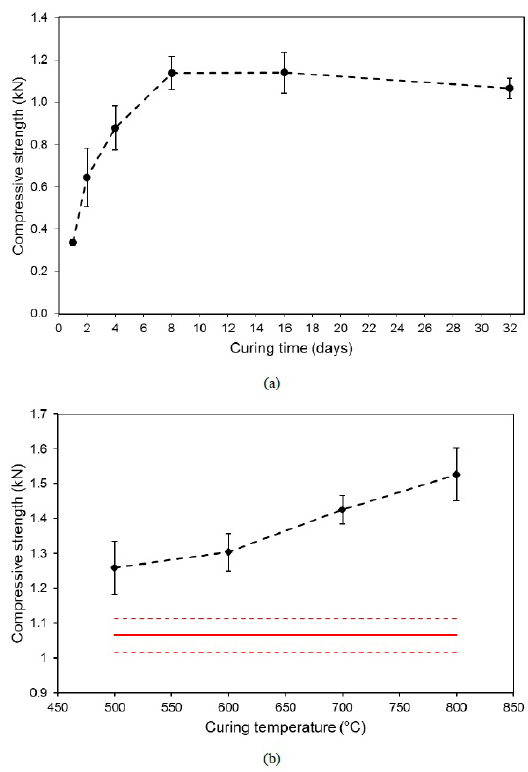
Figure 1. The compressive strength of 3 wt% sodium silicate-water pellets air-dried for up to 32 days (a) and sintered at 500 – 800 °C (b). The compressive strength of 32-day air-dried pellets presented in (a) were included in (b) as the reference; compressive strength – solid red line, standard deviation – dashed red